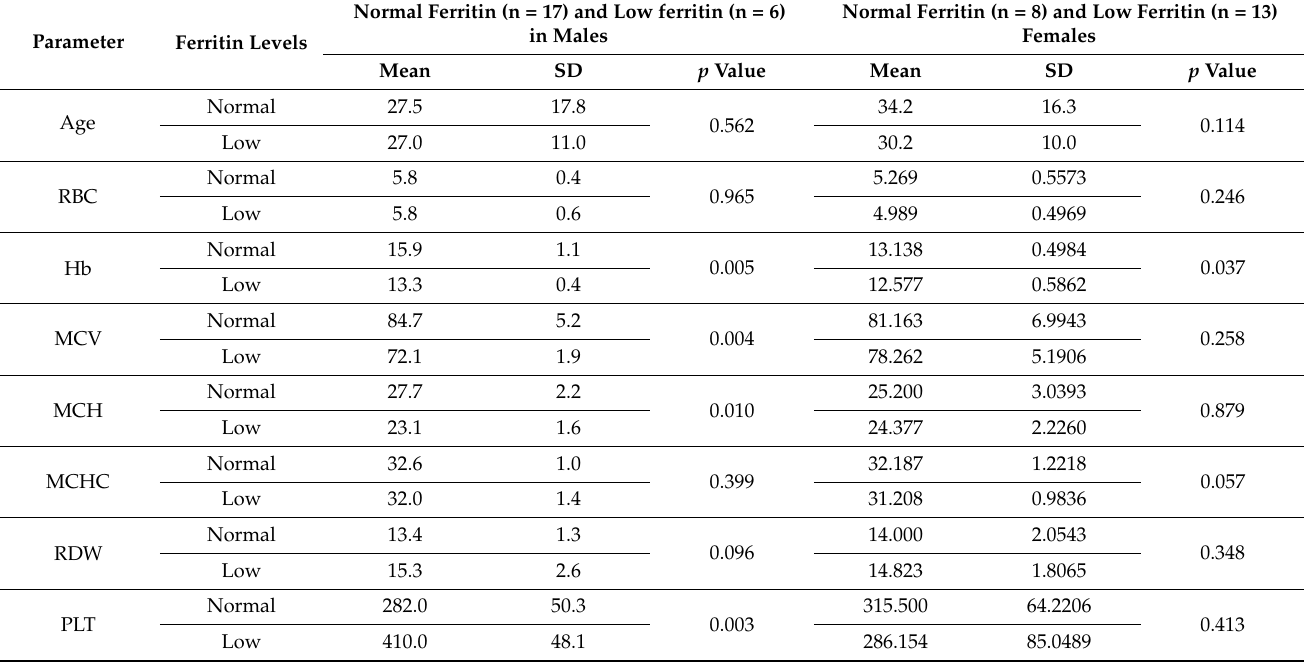
Table 2. Clinical data of normal hemoglobin individuals classified based on ferritin level and